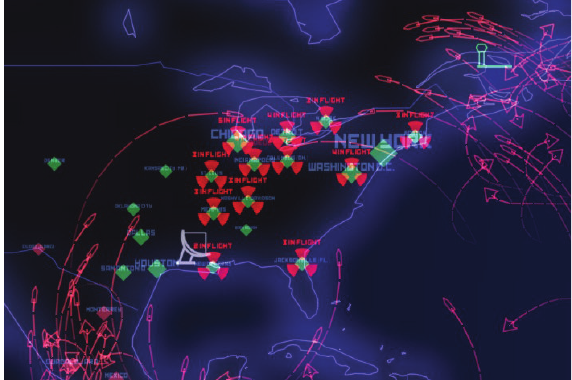
Figure 8: Synchronized attack in